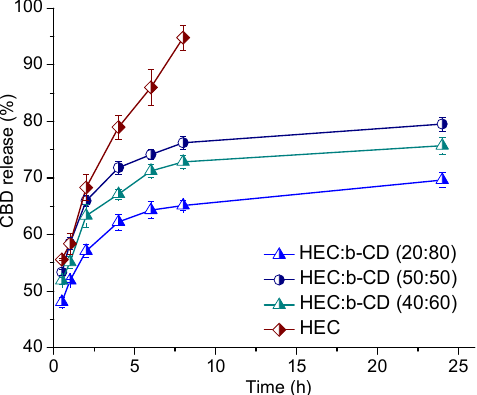
Figure 7. In vitro drug release of cannabidiol-loaded pure HEC and HEC/ β -CD macroporous cryogel carriers in acetate buffer (pH = 5.5) at 35 ◦ C. Mean values ± SD ( n = 3).